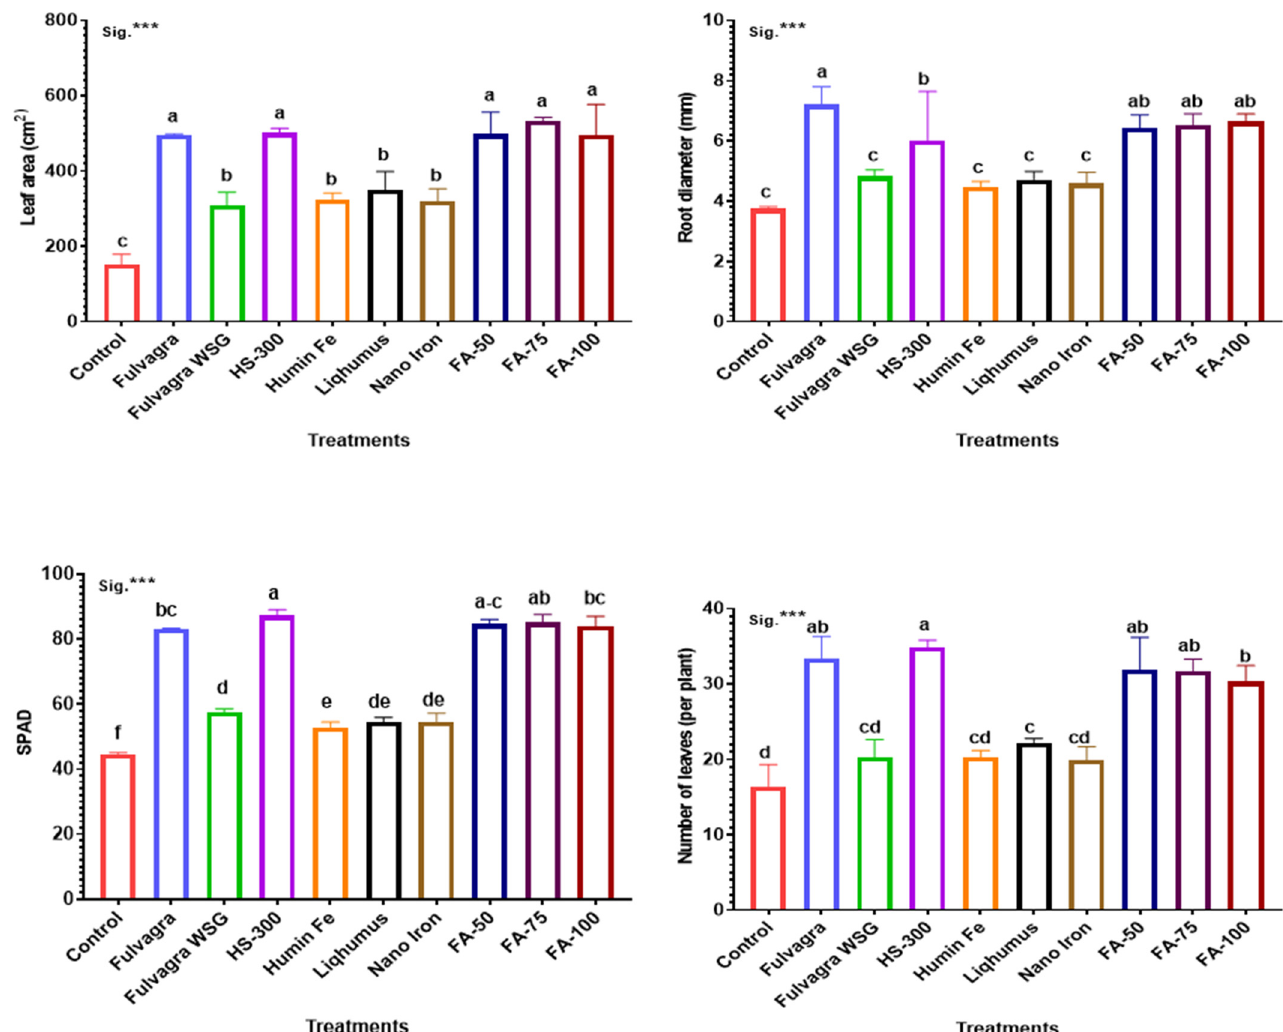
Figure 4. The effects of different treatments on root diameter, leaf number, leaf area, and SPAD value of spinach. Treatments Fulvagra, Fulvagra WSG, HS-300, Humin Fe, and Liqhumus contain FeSO 4 · 7H 2 O; treatments Nano Iron, FA-50, FA-75, and FA-100 contain nano ferrihydrite. The iron concentration in all treatments is 20 mM. The mean values with the same letter within the same column are not significantly different (***: p > 0.001).